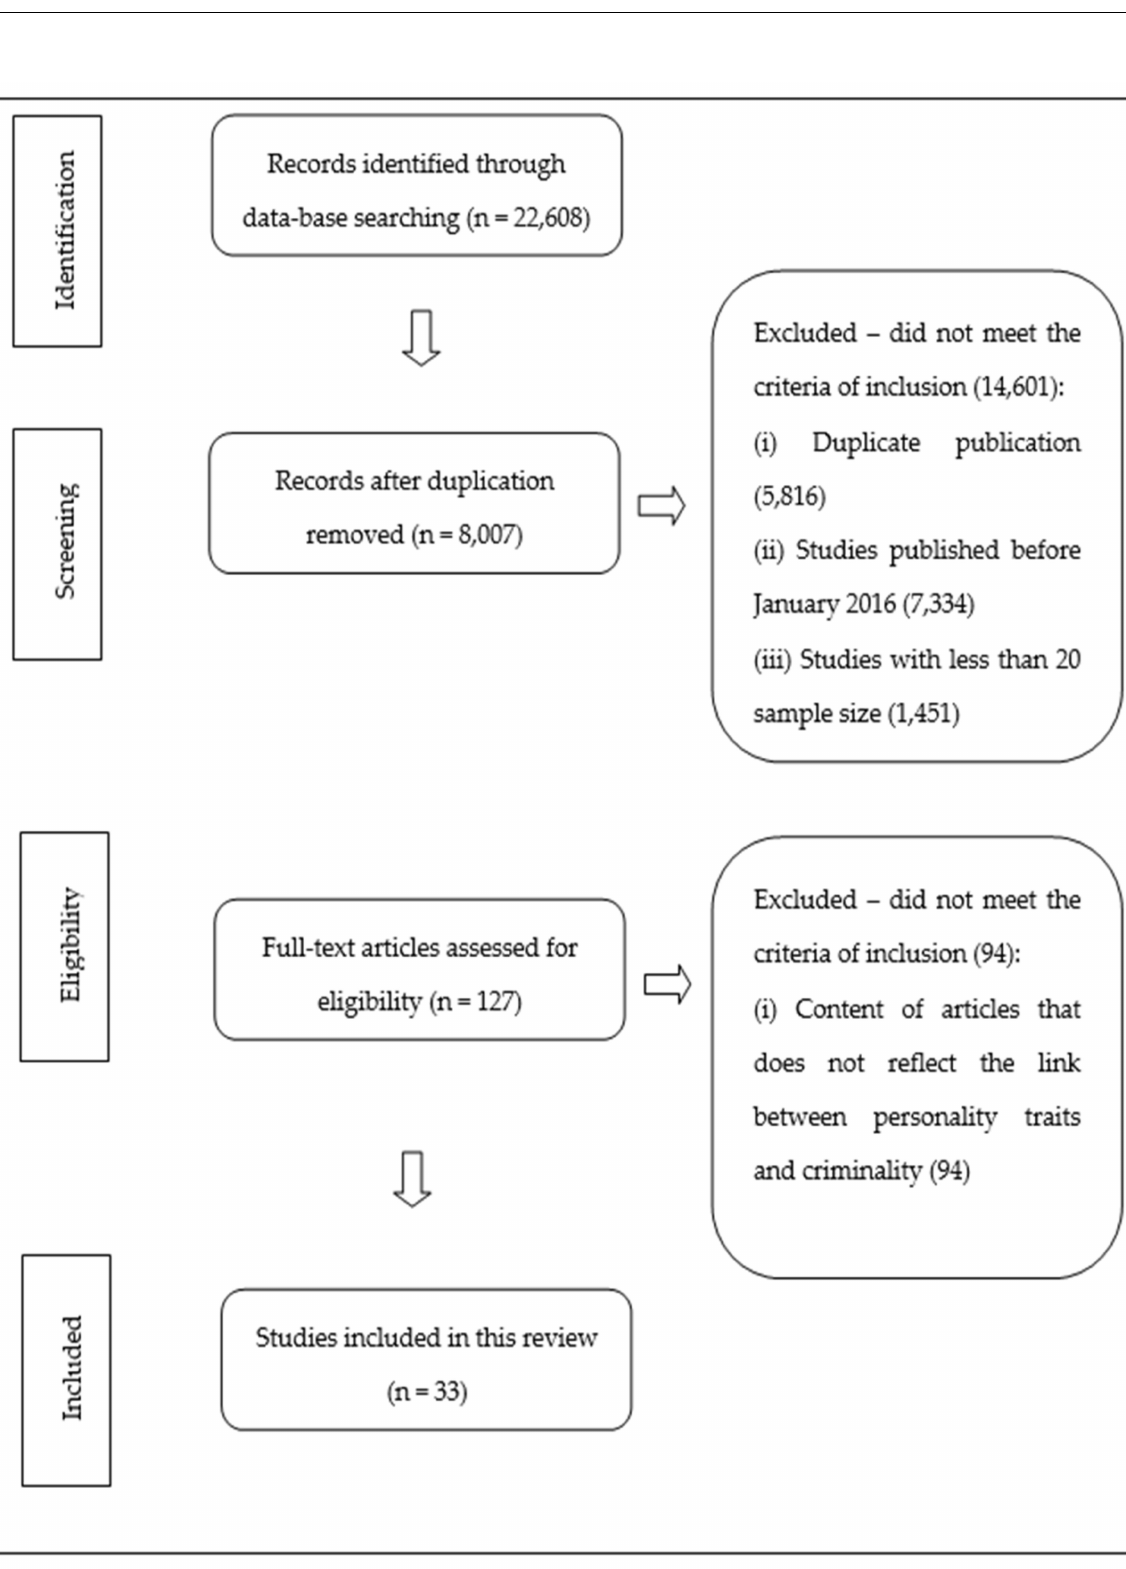
Figure 1. Flowchart of the Preferred Reporting Items for Systematic Review and Meta-Analyses